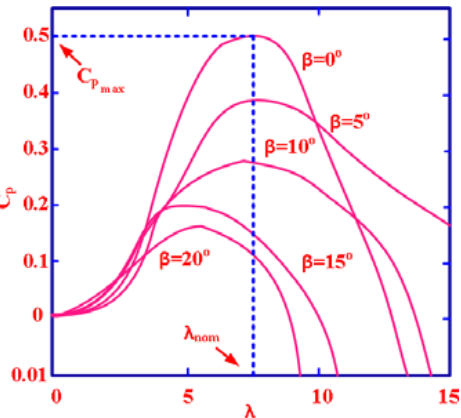
Figure 3. CPR (Performance coefficient) Vs tip speed ( λ T.S ) curve is plotted for different β P.B (Pitch blade angle).